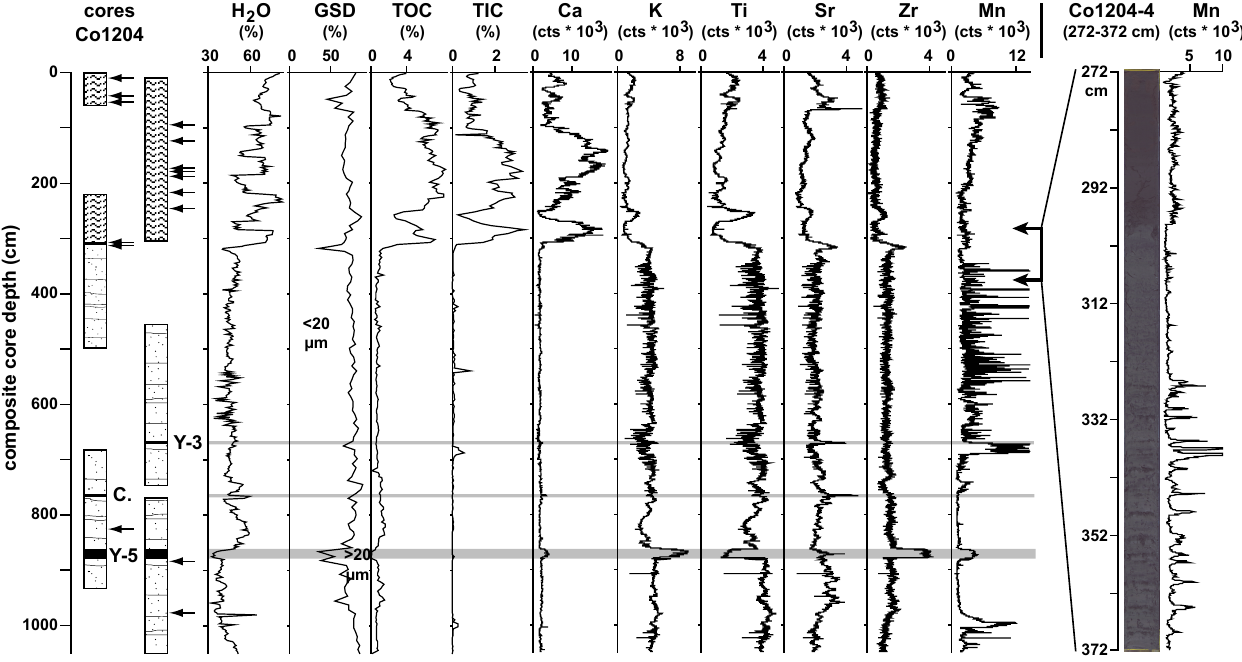
Fig. 2. Lithology, water content, grain-size distribution (GSD), total organic carbon (TOC), total inorganic carbon (TIC), and calcium (Ca), potassium (K), titanium (Ti), strontium (Sr), zirconium (Zr) and manganese (Mn) counts of composite core Co1204 from Lake Prespa. Individual core segments are indicated to the left. Arrows indicate horizons, which were used for radiocarbon dating. Black bars in the lithology mark tephra horizons. The line scan photo to the right is from core segment Co1204-4, 272–372cm field depth. This segment contains the transition from greyish Pleistocene sedimentation (bottom) to olive to brownish Holocene sedimentation (top). Maxima in Manganese (Mn) counts from XRF scanning in this segment correlate with dark grey spots or horizons and indicate occurrence of